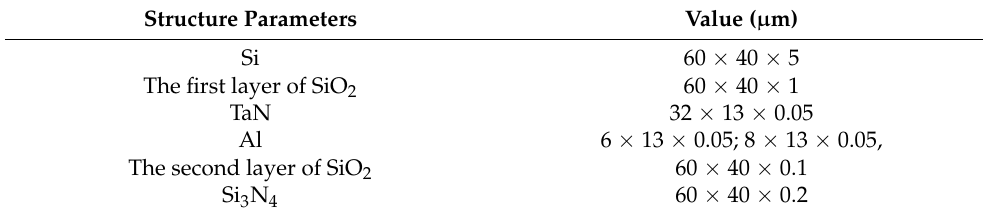
Figure 2. The fabrication of the TaN chopsticks-shaped heating resistors. ( a ) Using bare silicon as the base. ( b ) Deposition of the first layer of SiO 2 . ( c ) Deposition of heating resistors. ( d ) Aluminum as electrode. ( e ) Deposition of the second layer of SiO 2 . ( f ) Deposition of Si3N4 film. Table 1. The design parameters of the heating resistors.